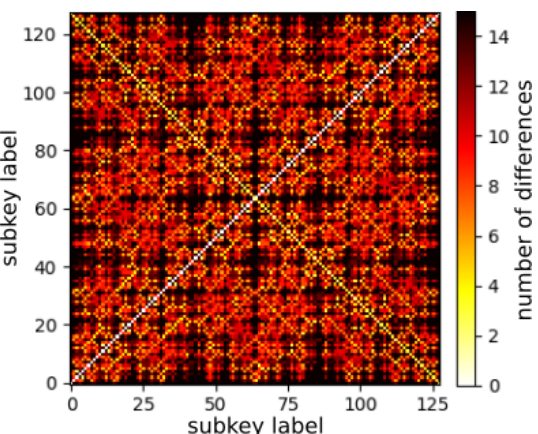
Figure 20: Number of differences between pairs of simulated trace means for all 128 classes of one subkey using 1 million traces. Pairs of identical profiles appear as white